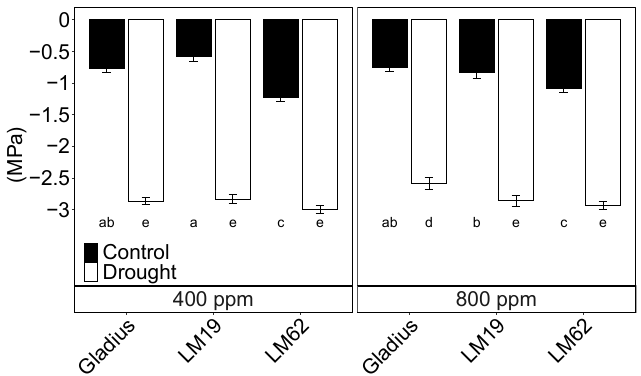
Figure 1. Midday leaf water potential of three spring wheat genotypes (Gladius, LM19 and LM62) under well-watered conditions (Control, black bars) or affected by drought (Drought, white bars) at aCO 2 (400 ppm) and eCO 2 (800 ppm). The measurements were conducted on a flag leaf around anthesis (BBCH = 65). Values are mean ± standard error of the mean (SE) ( n = 4). Values that share a letter are not significantly different according to Tukey’s honestly significant test ( p < 0.05).